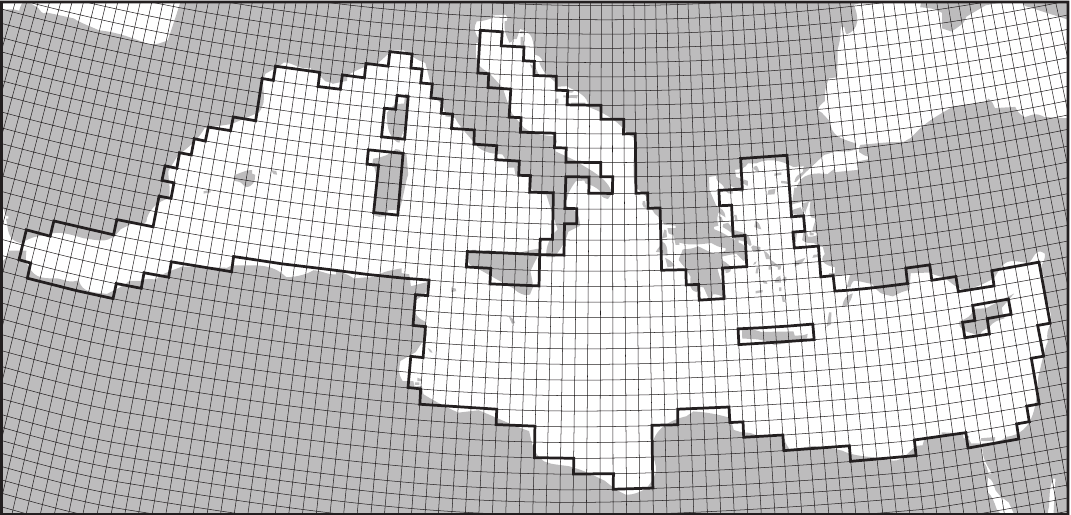
F IG . 1. – Grid of one-half degree lat-long quadrangles used for data summarization. The heavier line separates the grid cells that were select- ed as being “land” areas, where sea surface wind stress is defined to be zero, and grid cells considered as being “sea” areas where character- istic sea surface wind stress estimates are produced from maritime reports. Thus this heavier line operates as the effective coastal boundary in the wind stress curl and vertical velocity